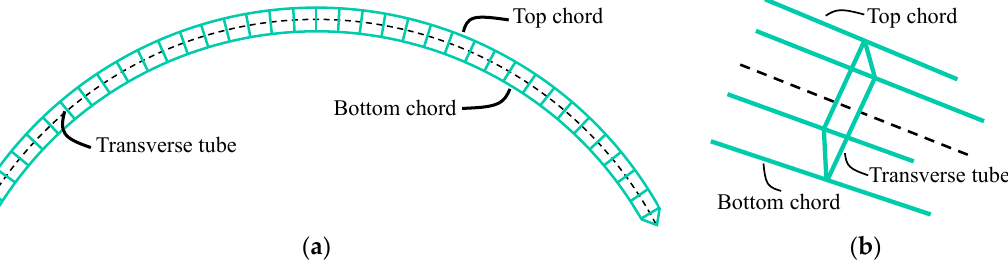
Figure 2. Schematic model of a typical circular steel tubular Vierendeel truss arch with rectangular section. ( a ) Elevation. ( b ) Diaphragm.